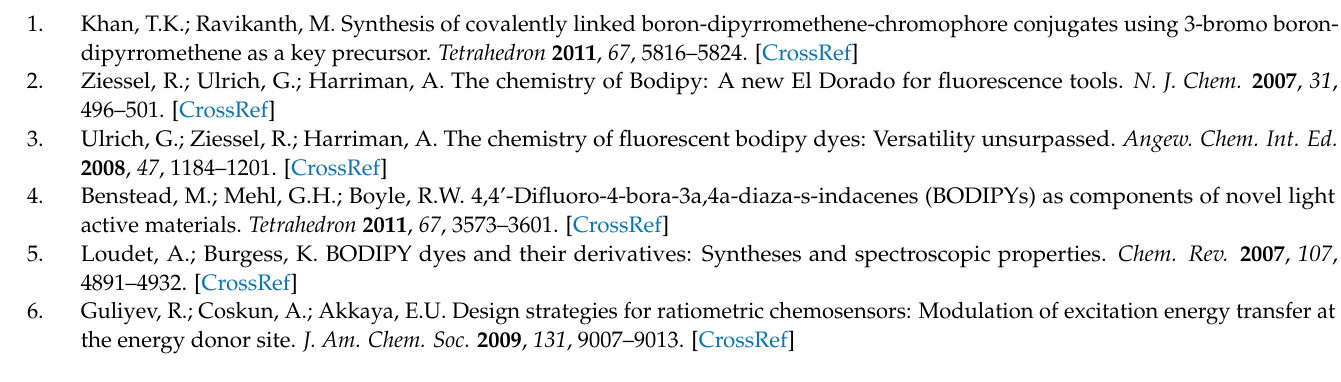
Figure 8. Energy level diagrams for BDP – TTP and 3BDP – TTP compounds.